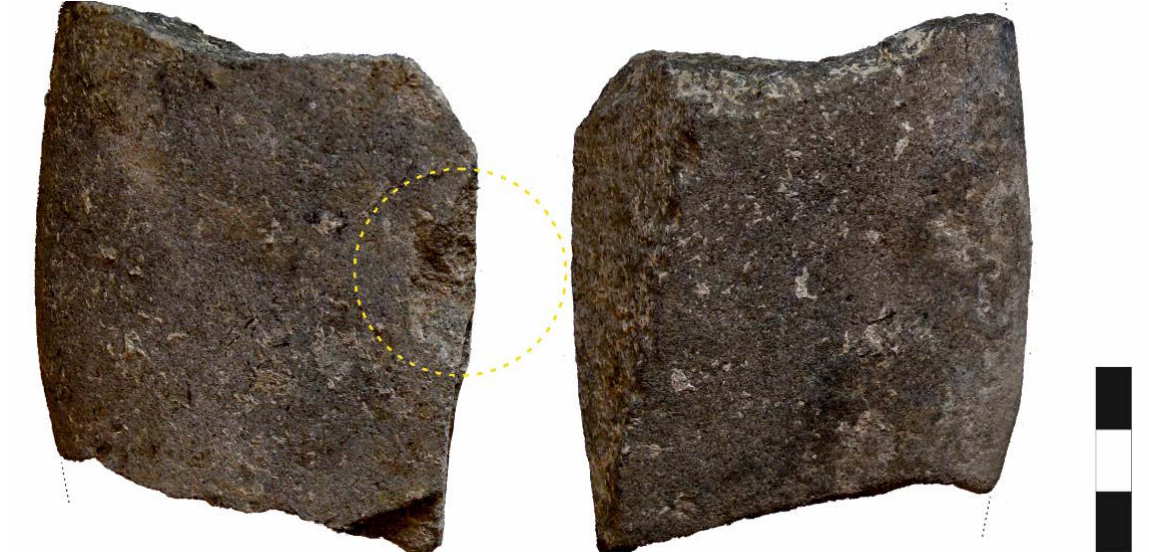
Figure 8. Grinding slab fragment with visible impact point (indicated with a circle). Workface and dorsal face (scale in